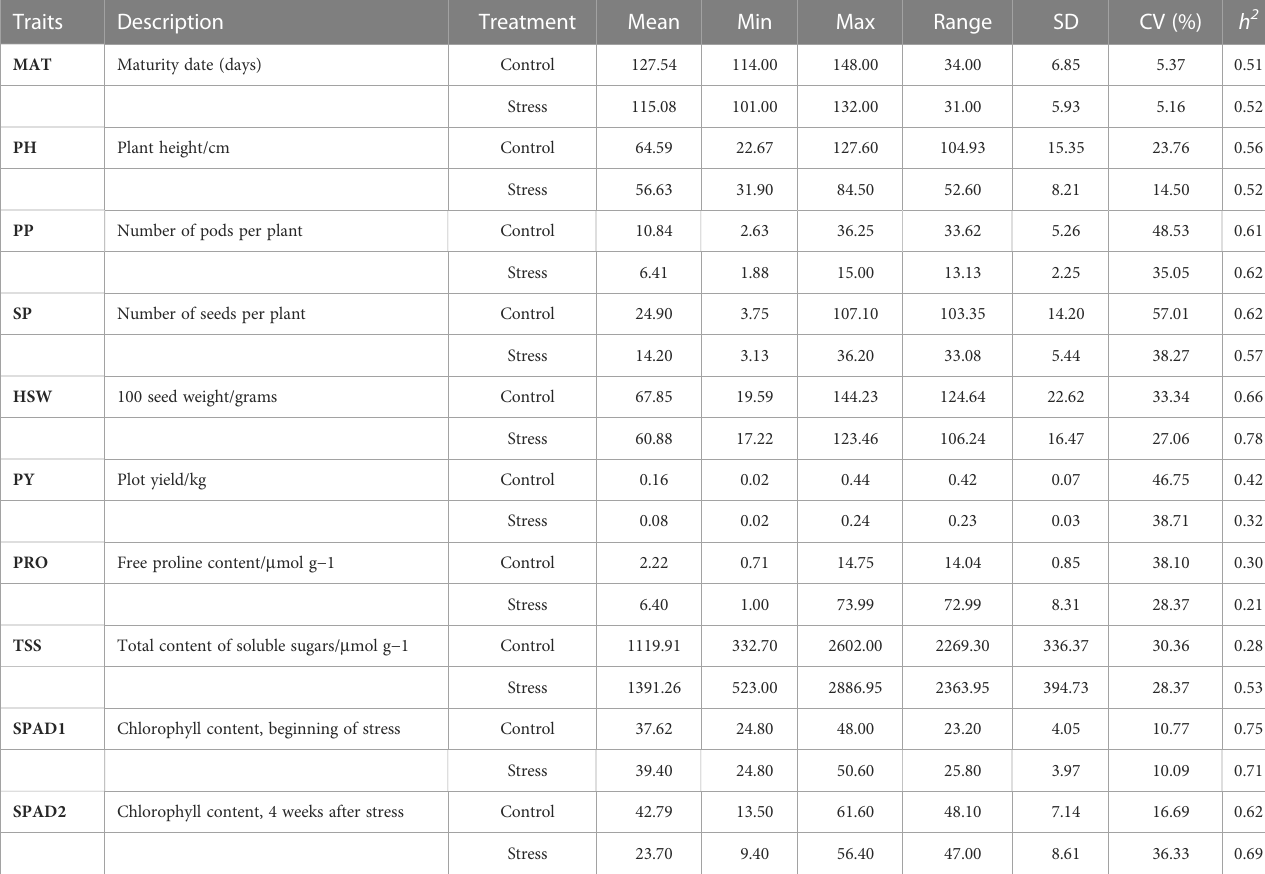
TABLE 1 Statistical analysis of 10 morphological, phenological and physiological traits in controlled and drought stress conditions. Traits Description